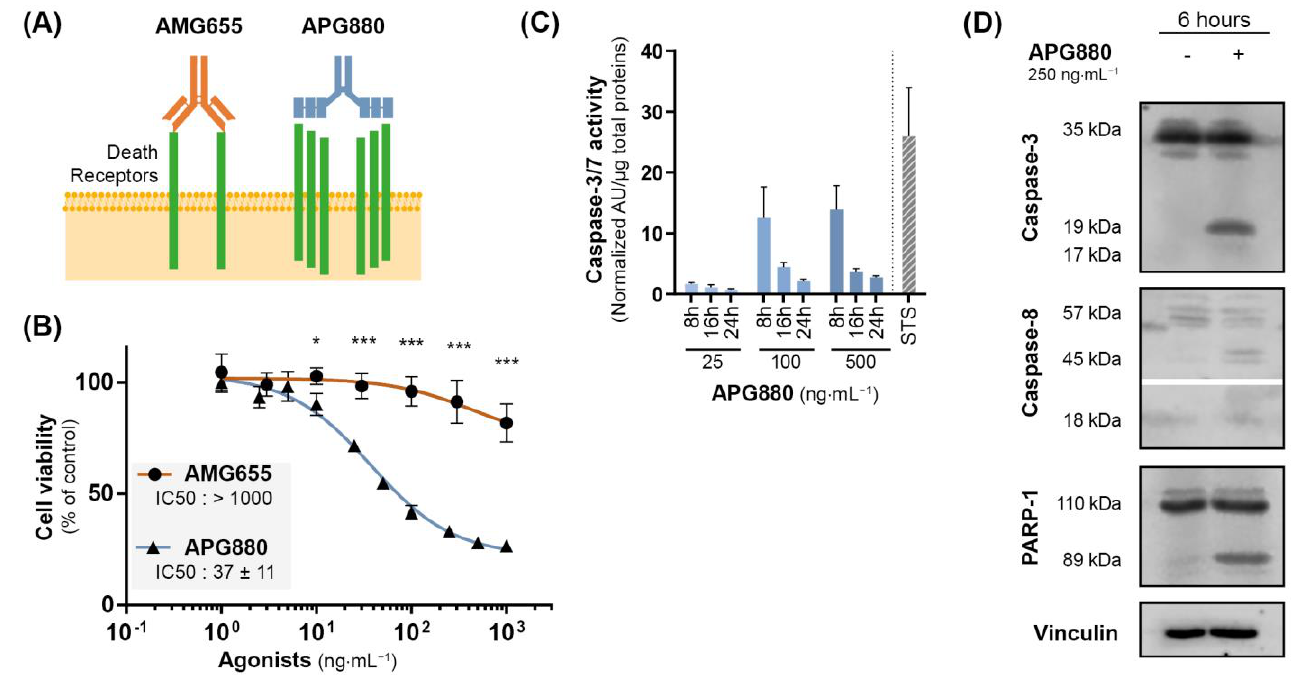
Figure 5. APG880, a TRAIL-death receptors multiple agonist is able to induce apoptosis in K- HOS cells. ( A ) Comparison between the immunoglobulin AMG655, and APG880 which consists of an assembly of two trimeric TRAIL chain molecules covalently fused with the Fc fragment of a human immunoglobulin. While AMG655 can only bind two DR5, APG880 has been designed to bind six TRAIL death receptors. ( B ) Cells were cultured for 72 h in the presence of increasing concentrations of AMG655 or APG880. IC50s were determined by crystal violet staining. ( C ) Sensitivity to APG880-induced apoptosis was assessed by specific enzymatic assay of caspase-3/7 activity. K-HOS cells were treated with either 25, 100, or 500 ng ⋅ mL − 1 of APG880, the cells were then lysed, and total proteins were extracted 8 h, 16 h, or 24 h following the treatment. The caspase-3/7 enzymatic activity was measured by Apo-ONE ® Homogeneous Caspase (Promega); the results were normalized to total protein. Staurosporine 1 µ M (STS) for 8 h was used as positive control of apoptosis induction. ( D ) Kinetics of caspase-3, caspase-8, and PARP-1 cleavages in K-HOS cell line after 6 h of treatment with 250 ng · mL − 1 APG880 was determined by Western blot. Vinculin was used as loading control. (* p < 0.01, *** p <